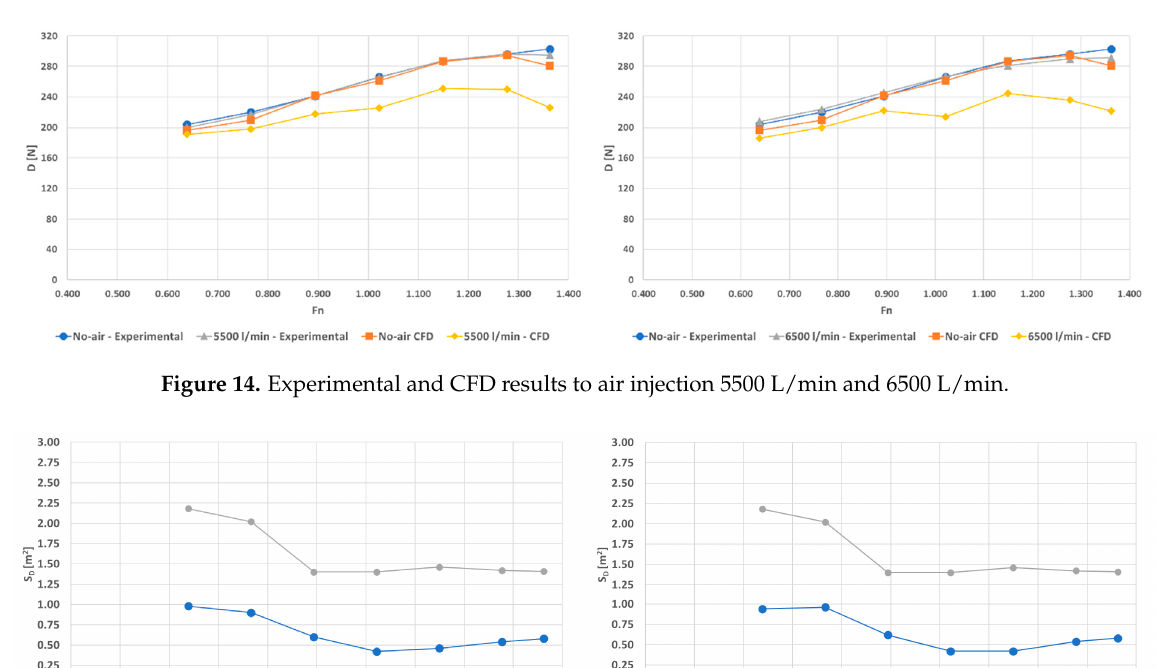
Figure 14. Experimental and CFD results to air injection 5500 l/min and 6500 L/min.